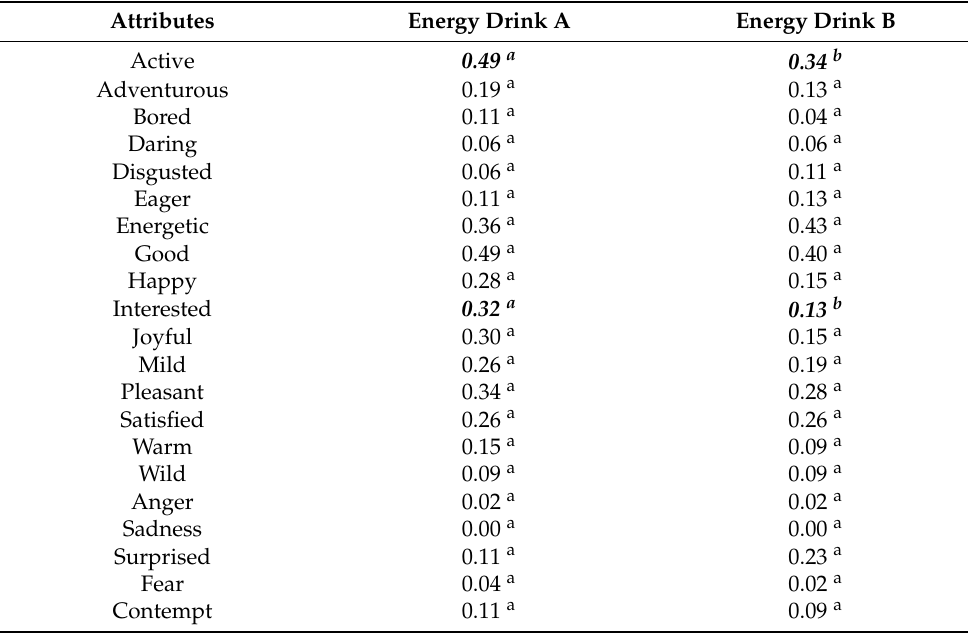
Table 4. Emotions felt after tasting energy drink A and B from Cochran’s Q